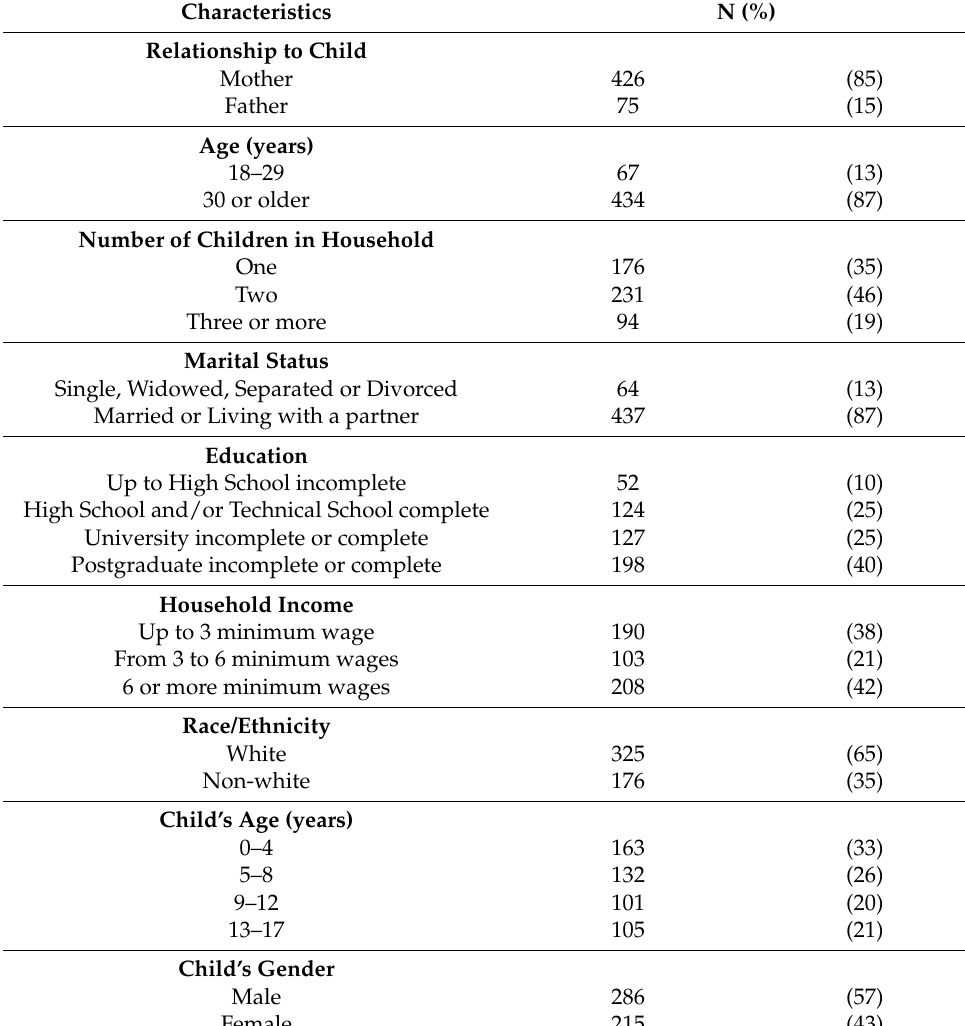
Table 1. Characteristics of the caregivers (N =